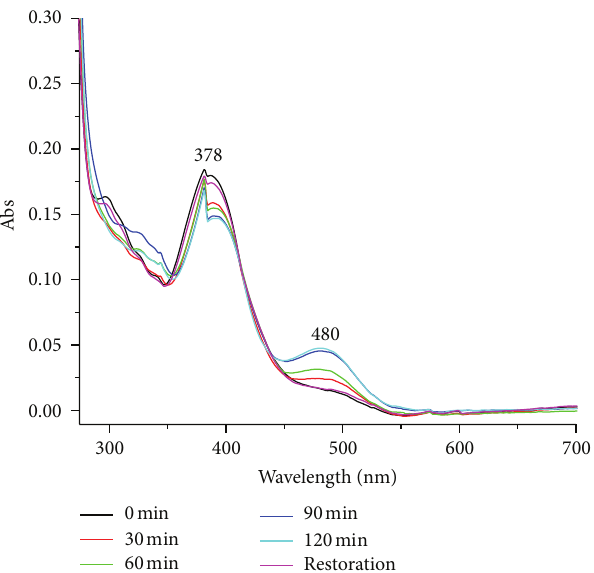
Figure 5: The UV-vis spectra of compound 2 after a period of exposure to UV light.